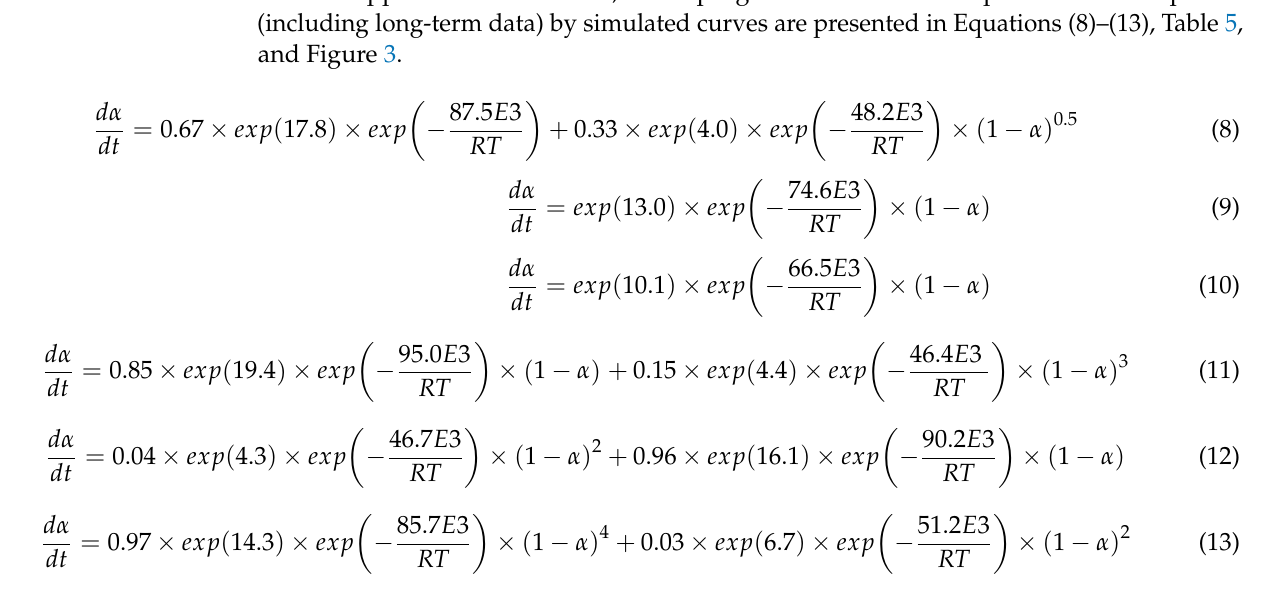
Table 5. Experimental vs. predicted increase of HMWP (in %) for three different peptide formulations in two different packaging materials combined into six drug products after storage for two years at 5 ◦ C and after a subsequent in-use period of 28 days at 30 ◦ C. The corresponding plots and rate equations are provided in Figure 3 and Equations